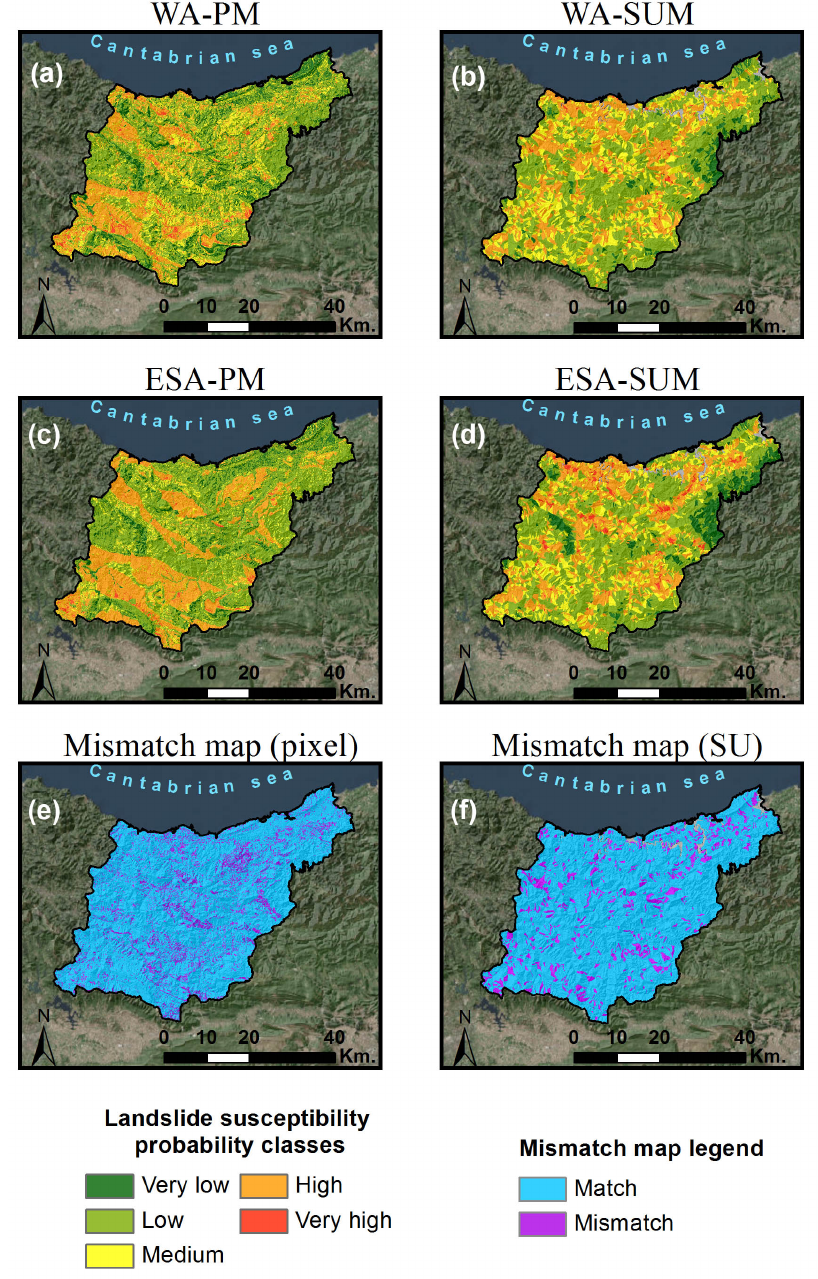
Figure 5. (a–d) Landslide susceptibility maps represented in five classes for WA-PM, WA-SUM, ESA-PM and ESA-SUM. (e, f) Mismatch maps representing the spatial distribution of the mapping units differently classified using ESA between pixel models and slope unit